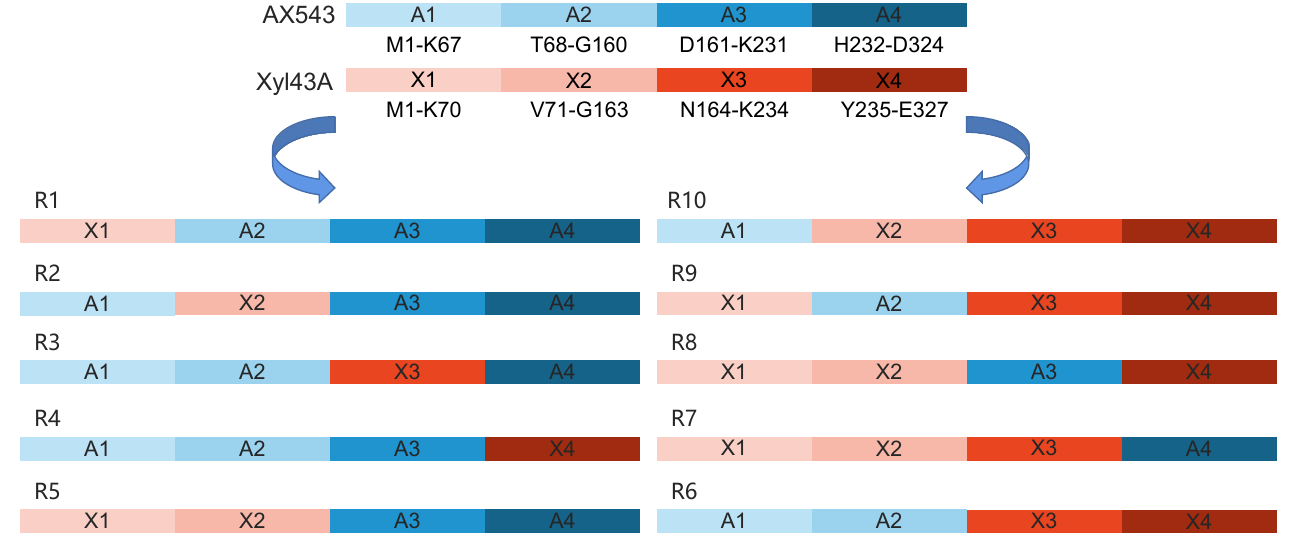
Figure 8. The schematic diagram of molecular construction of chimeras.